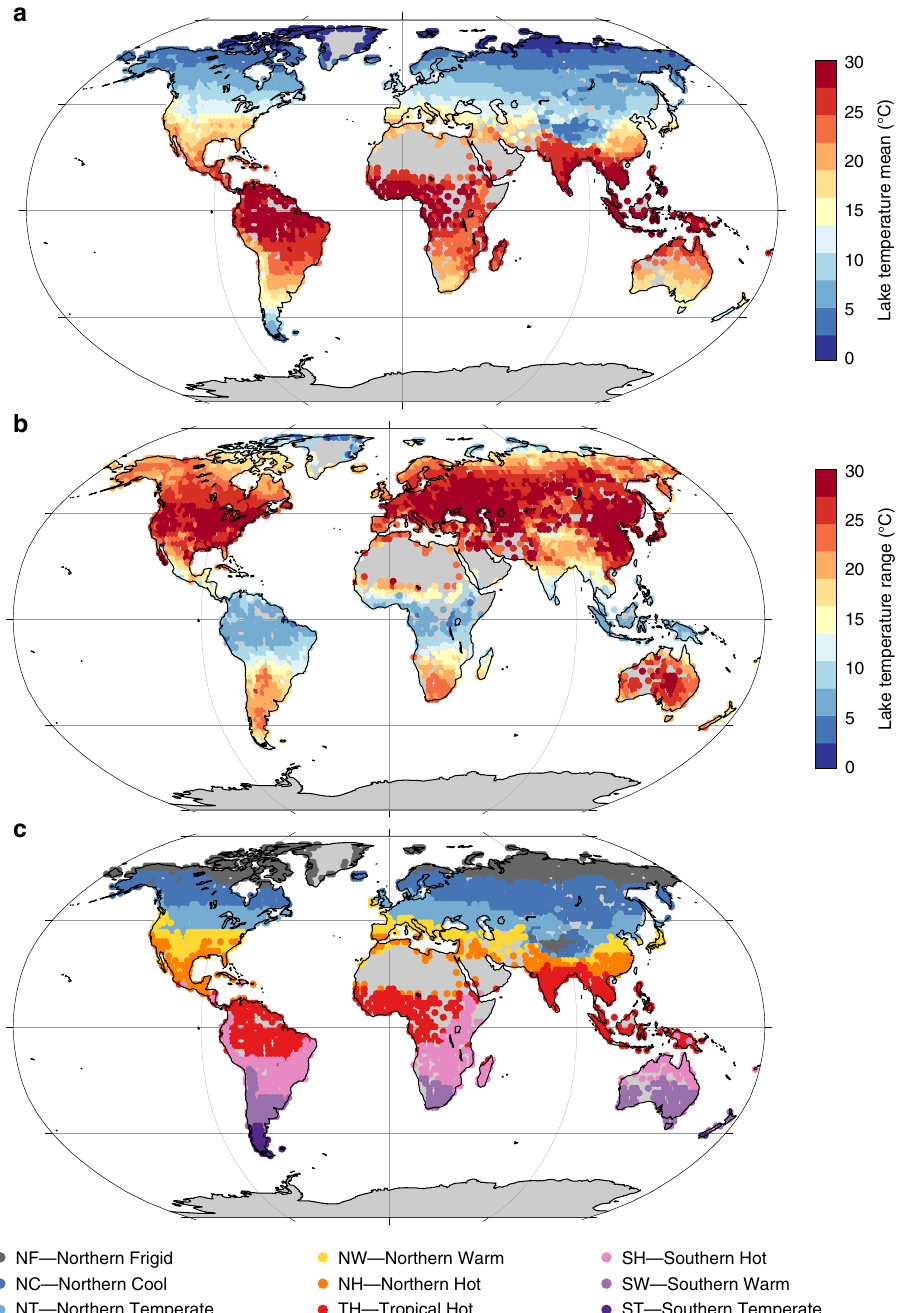
Fig. 2 Modelled lake surface water temperature dynamics. a Mean lake surface water temperature. b Seasonal range in lake surface water temperature. c Map of the nine lake thermal regions. Locations represent 2° grids where lakes exist based on the HydroLAKES database (see methods); grey areas are where lakes are absent in the database. Lake surface temperatures and the thermal regions were calculated by the lake model driven by ERA-Interim data from 1996 to